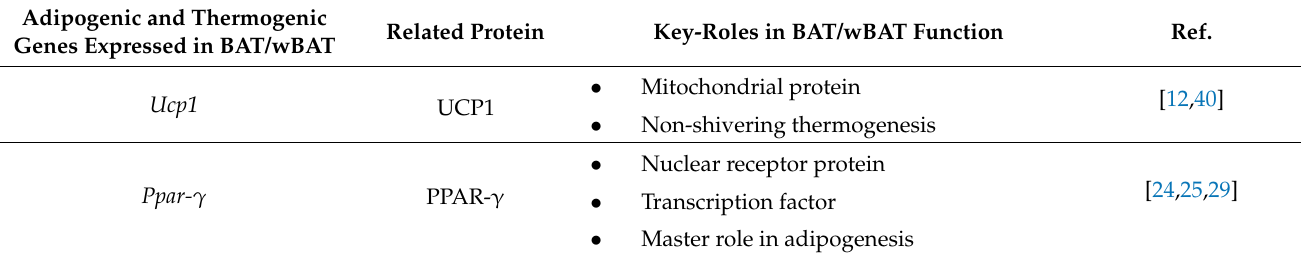
Table 1. Overview of common genes expressed in both brown adipose tissue (BAT) and white adipose tissue-derived brown-like adipose tissue (wBAT) with adipogenesis and/or non-shivering thermogenesis implications. They constitute potential targets for induction of browning and BAT activity. Adipogenic and Thermogenic Related Protein Key-Roles in BAT/wBAT Function Genes Expressed in BAT/wBAT